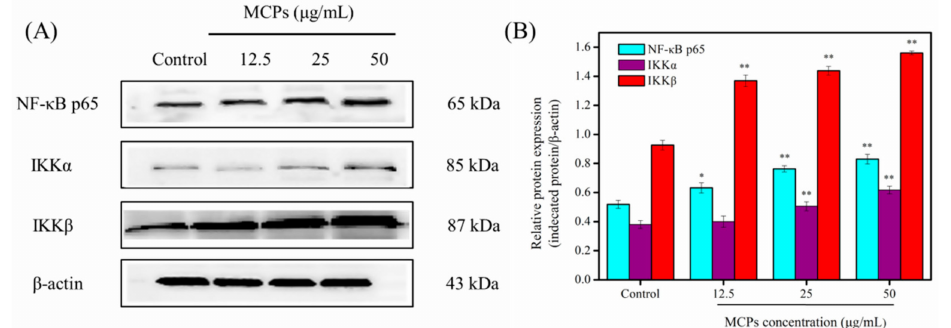
Figure 6. MCPs activated the NF- κ B signaling pathway and increased expression of its target pathways in NIH-3T3 fibroblast cells. ( A ) Western blot analysis of the NF- κ B p65, IKK α , and IKK β in the NIH-3T3 cells treated with di ff erent concentrations MCPs overnight. ( B ) The expression levels of NF- κ B p65, IKK α , and IKK β analyzed by western blotting. The data was obtained by using Image J 1.38 software and were expressed as the mean ± standard deviation ( x ± s , n = 6). * p < 0.05 and ** p < 0.001 vs.